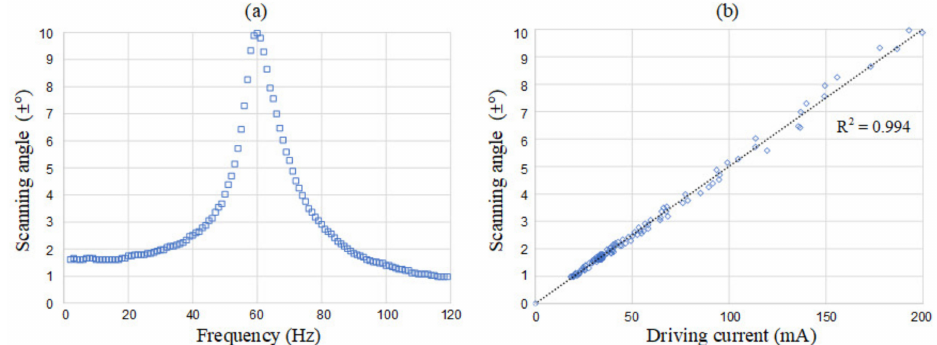
Figure 8. Characterization of the origami galvanometer. ( a ) Scanning angle versus driving frequency. ( b ) Scanning angle versus driving current.